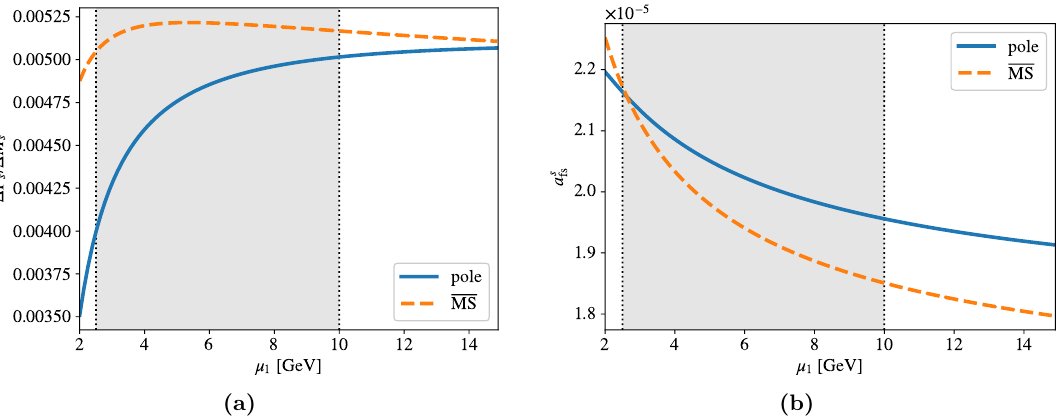
as a function of µ for the MS (dashed orange) and pole (solid blue) 1 fs used to obtain the renormalization 1